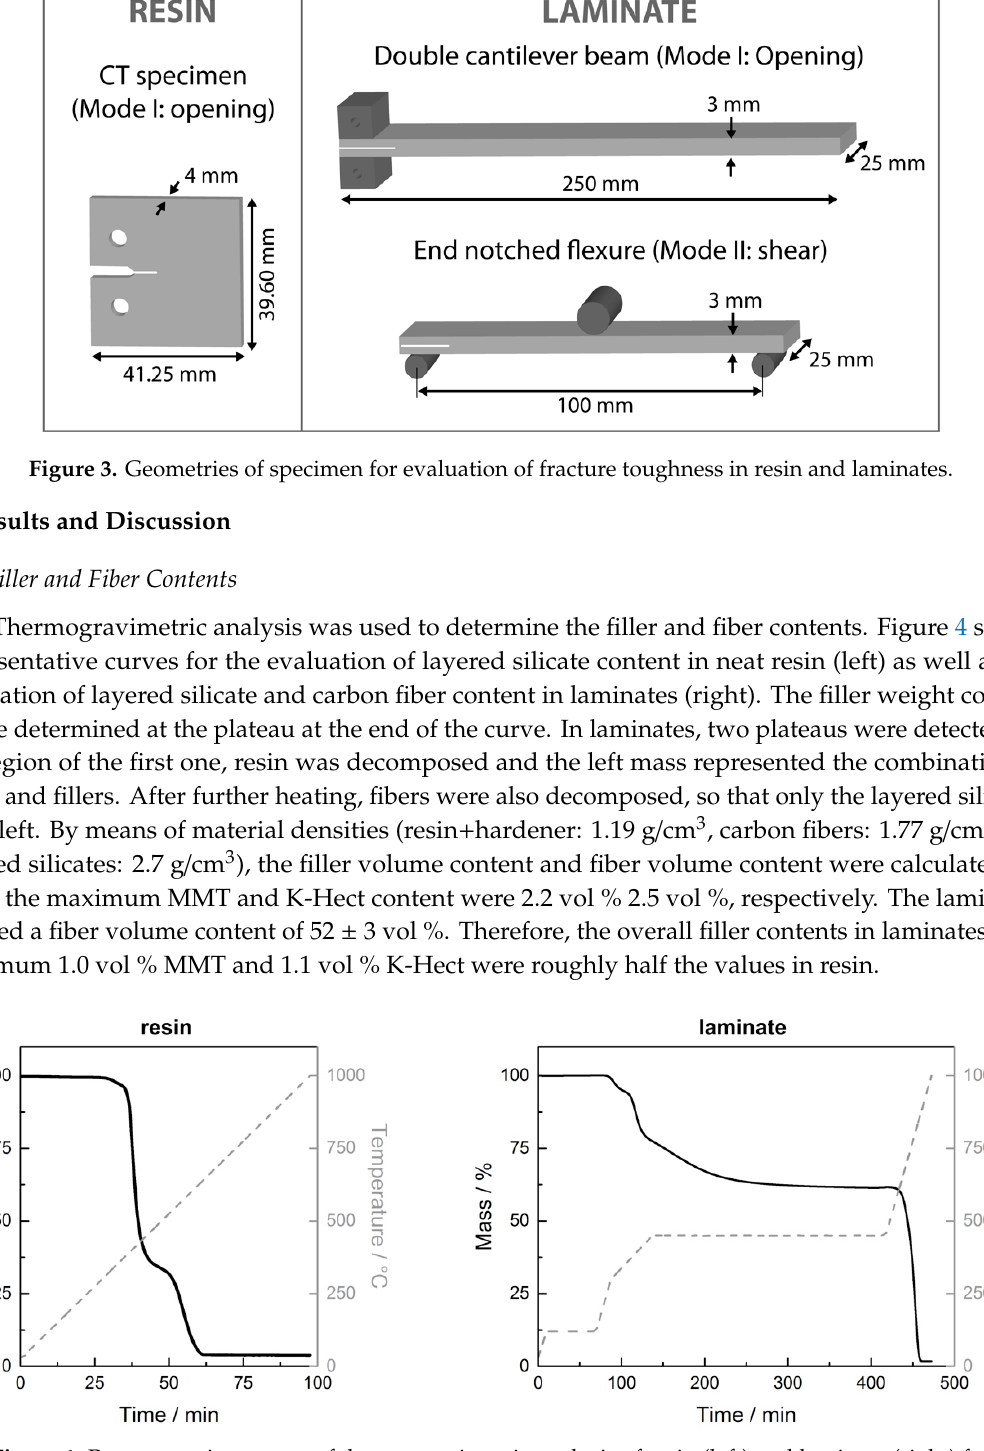
Figure 4. Representative curves of thermogravimetric analysis of resin (left) and laminate (right) for illustration of evaluation of filler and fiber content (here: samples with 6 wt % of K-Hect in neat resin).